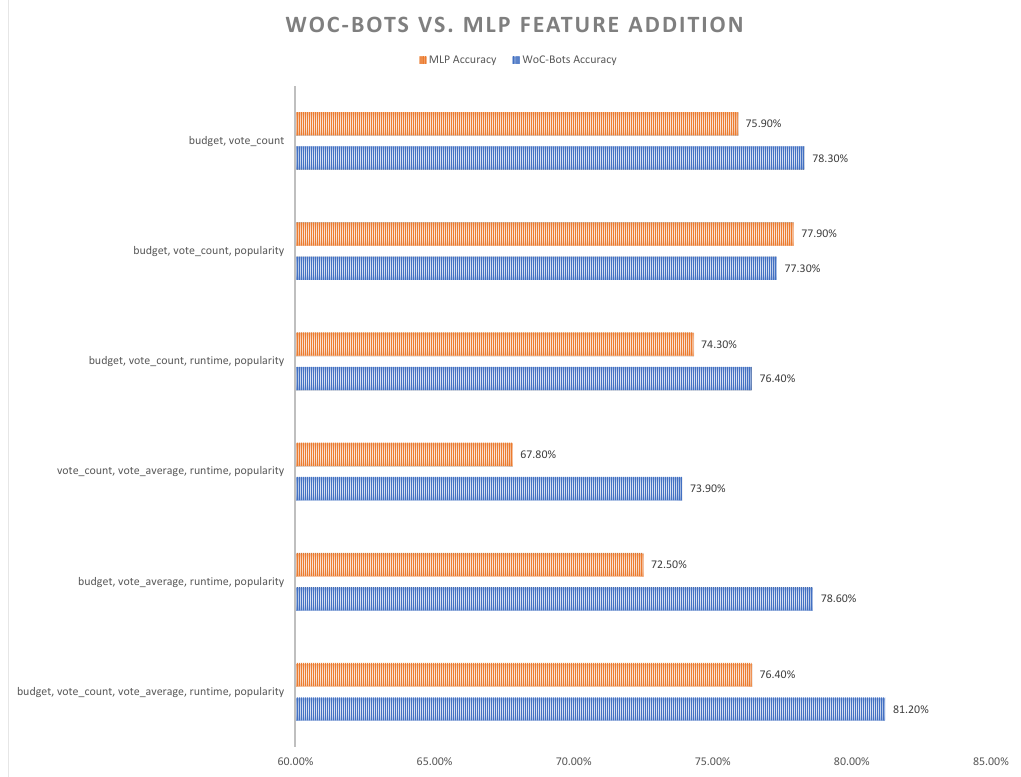
Figure 3. Accuracy of MLP vs WoC-Bots w/Max agent configuration while adding